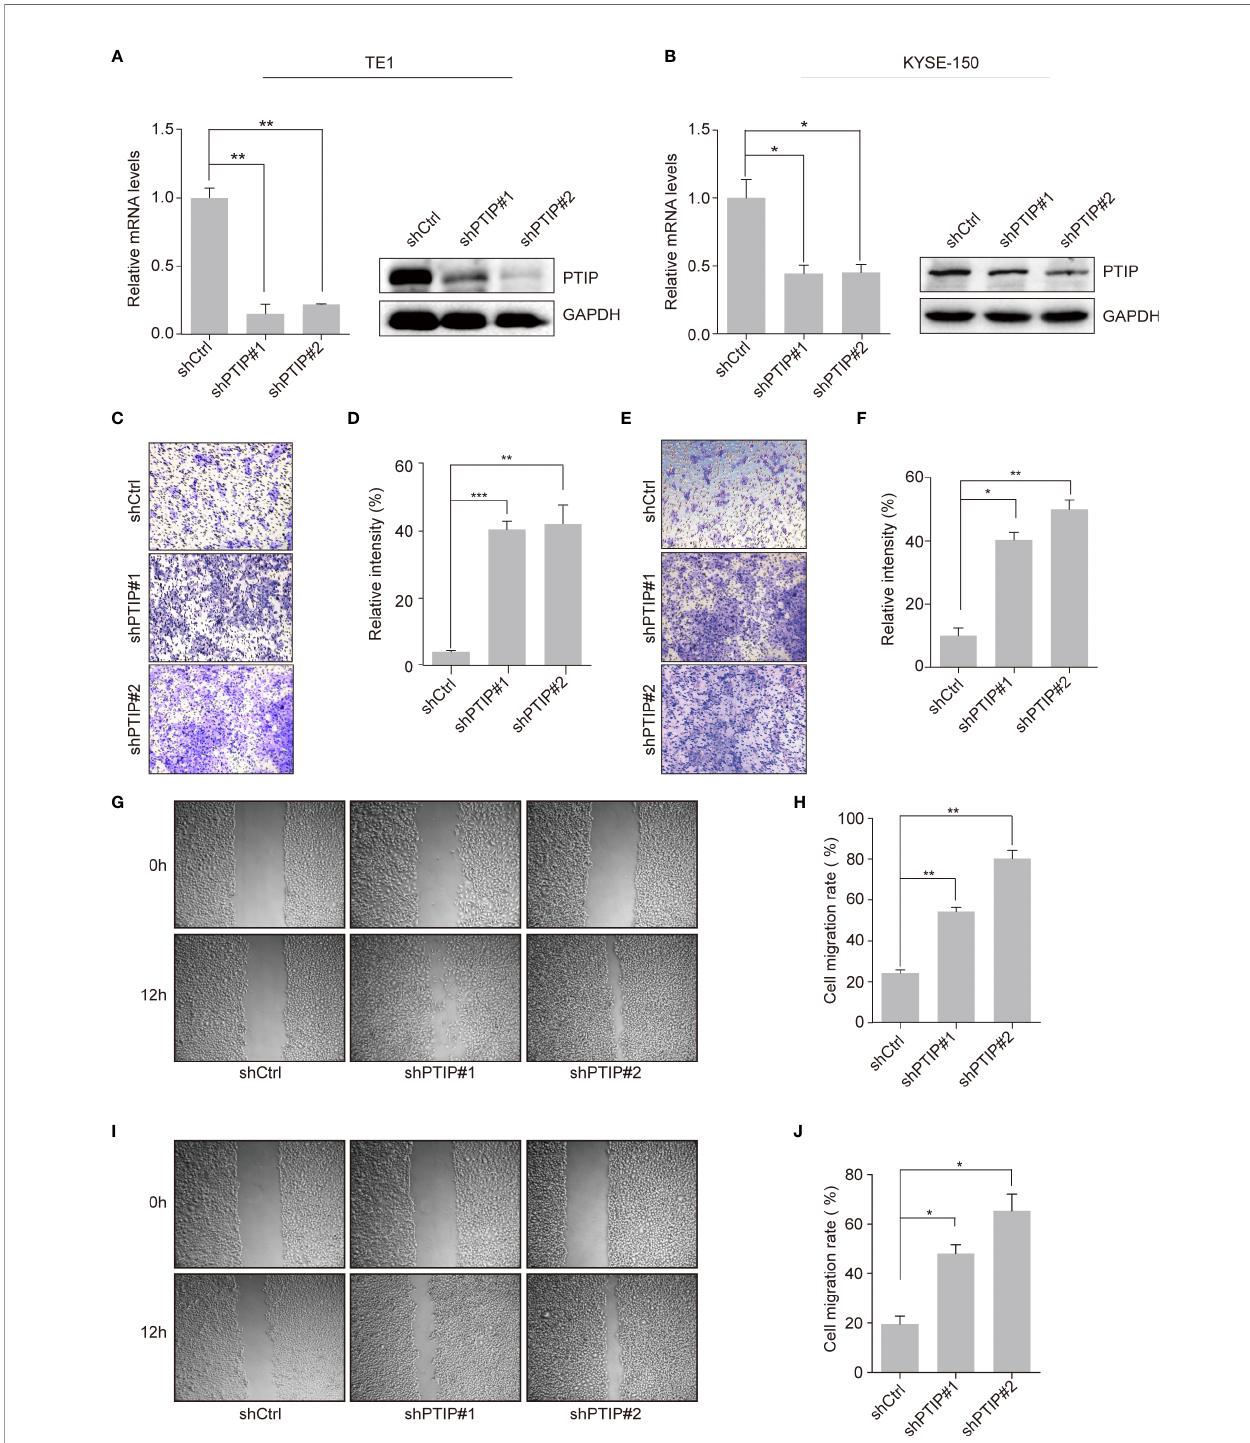
FIGURE 2 | Effects of PTIP on ESCC cell invasion and migration. (A, B) Knockdown ef fi ciency of two independent shRNAs targeting PTIP in TE1 (A) and KYSE-150 (B) cells as determined by qRT-PCR and Western blot. (C – F) The effect of PTIP knockdown on the invasiveness of TE1 (C, D) and KYSE-150 (E, F) cells. For invasion assay, six different microscopic fi elds (magni fi cation, ×10) from at least three independent experiments were examined; Relative intensities of the fi elds were measured (n ≥ 3). Representative images and statistical plots are shown; Mean ± s.d. are given for three independent experiments. One-way ANOVA; * P < 0.05, ** P < 0.01, *** P < 0.001. (G – J) Wound healing assay was performed to determine the cell migration in TE1 (G, H) and KYSE-150 (I, J) cells. Representative images and statistical plots are shown; Mean ± s.d. are given for three independent experiments. One-way ANOVA; * P < 0.05,** P <